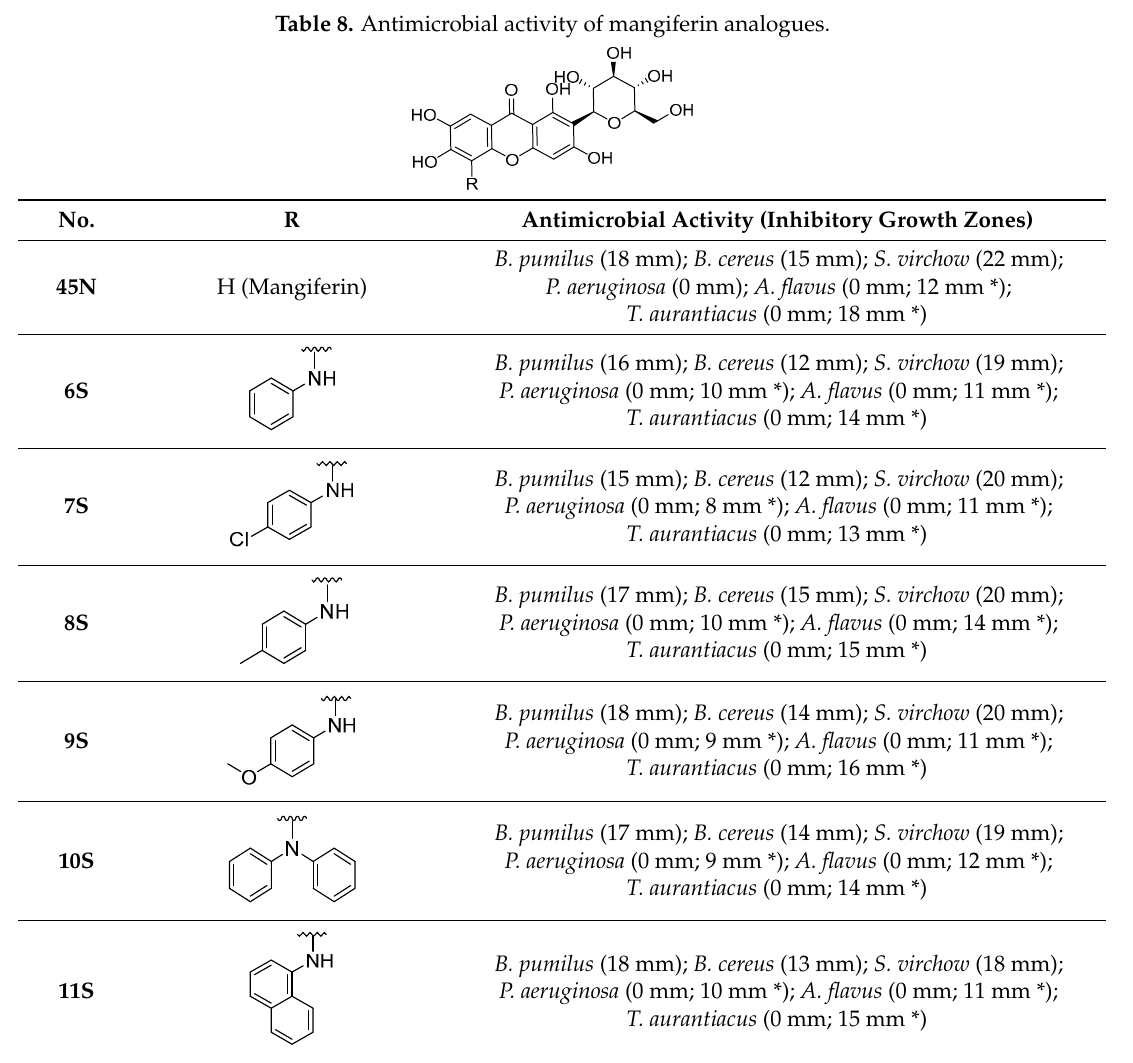
Table 9. Antimicrobial activity of amino acid xanthone derivatives.